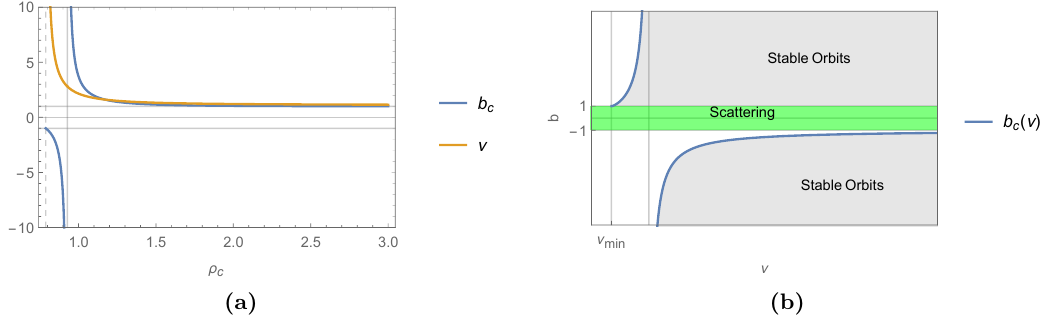
Figure 8. (a) Critical impact parameter b c and geometric parameter (cid:23) allowing for circular phton orbits as a function of the critical radius (cid:26) c , a is set to 1. (b) Parameter space for null geodesics with zero total angular